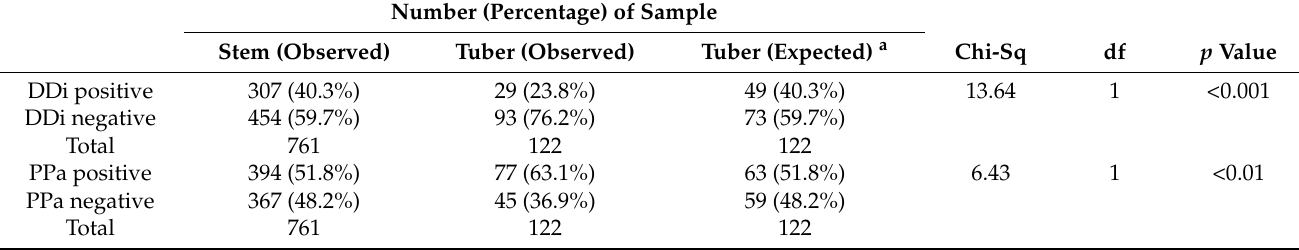
Table 2. Chi-square test on tissue distribution of Dickeya dianthicola (DDi) and Pectobacterium parmentieri (PPa) on potato tissues showing blackleg and soft rot